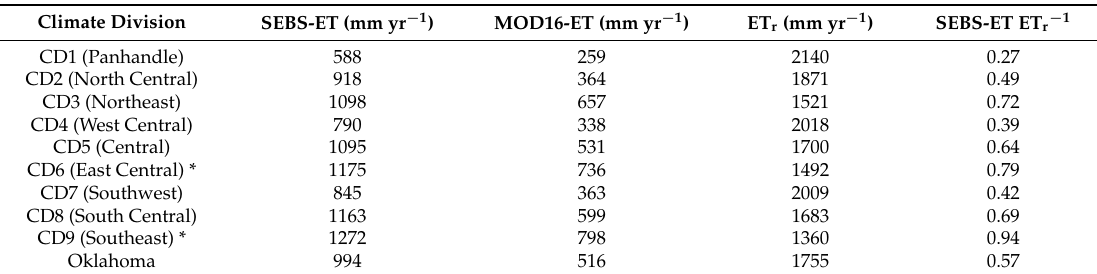
Figure 4. Annual ET maps (SEBS-ET) of Oklahoma from 2001 to 2014. The solid lines represent boundaries of the nine climate divisions. It should be noted that CDs 6 and 9 in southeast have a forested area of more than 29%. Hence, their ET estimates may not be accurate since the flux towers used in validation did not include forest land cover. Table 2. Average annual SEBS-ET, MOD16-ET, ET r and the ratio of SEBS-ET to ET r for all Oklahoma climate divisions (CD) during the 2001–2014 period.